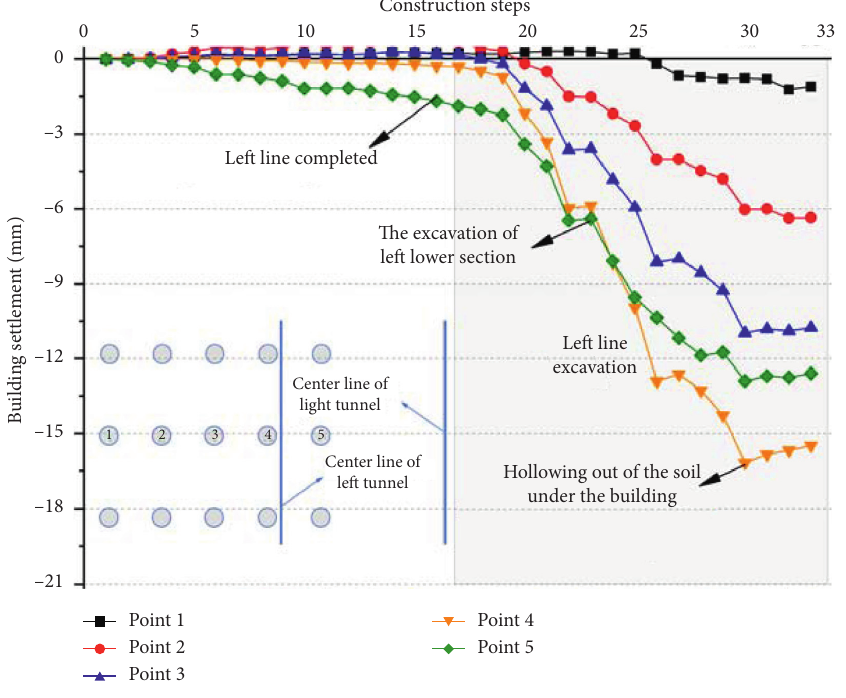
Figure 25: Building subsidence curves (pre-grouting).